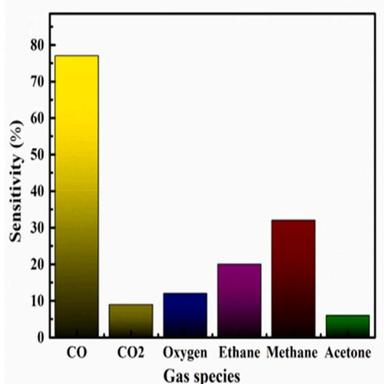
Selectivity v/s Gas species of ZnFe(2-x)LuxO4, where x = 0.01(Lu 0.01), 0.03(Lu 0.03), 0.05(Lu 0.05), 0.07(Lu 0.07).